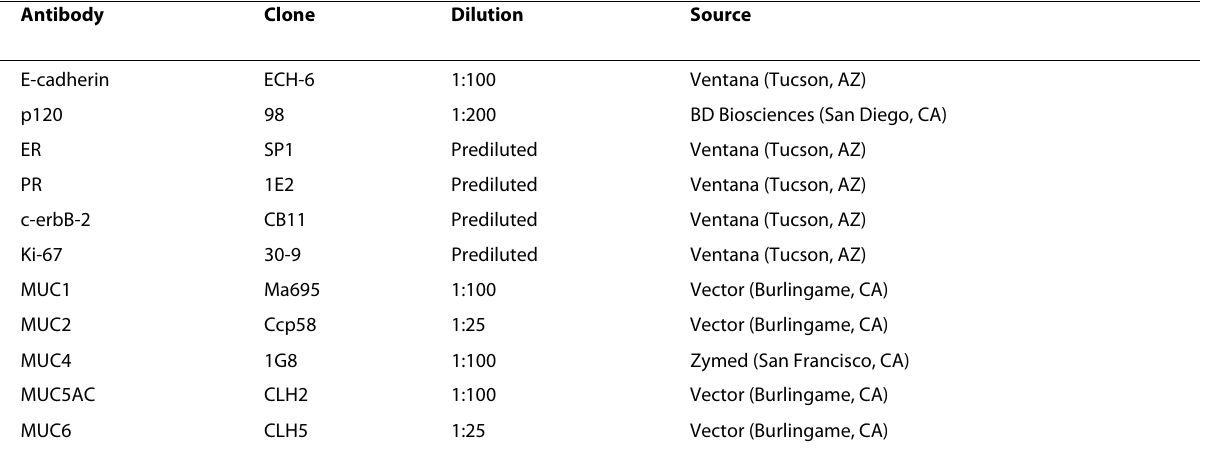
Table 1: Antibodies used for immunohistochemistry Antibody Clone